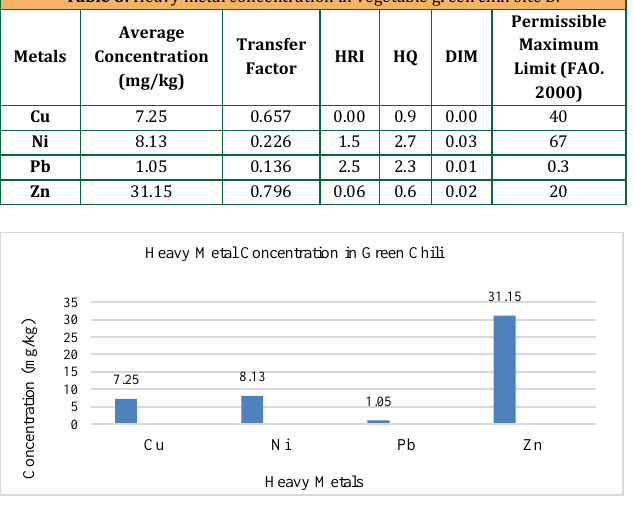
Figure 5: Average concentration in green chili site